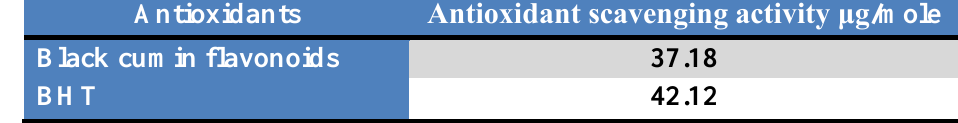
Table 3: Antioxidant scavenging activity of 0.02% black cumin flavonoids as compound to Butalated hydroxyl toluene (BHT) by DPPH scavenging assay in vitro.